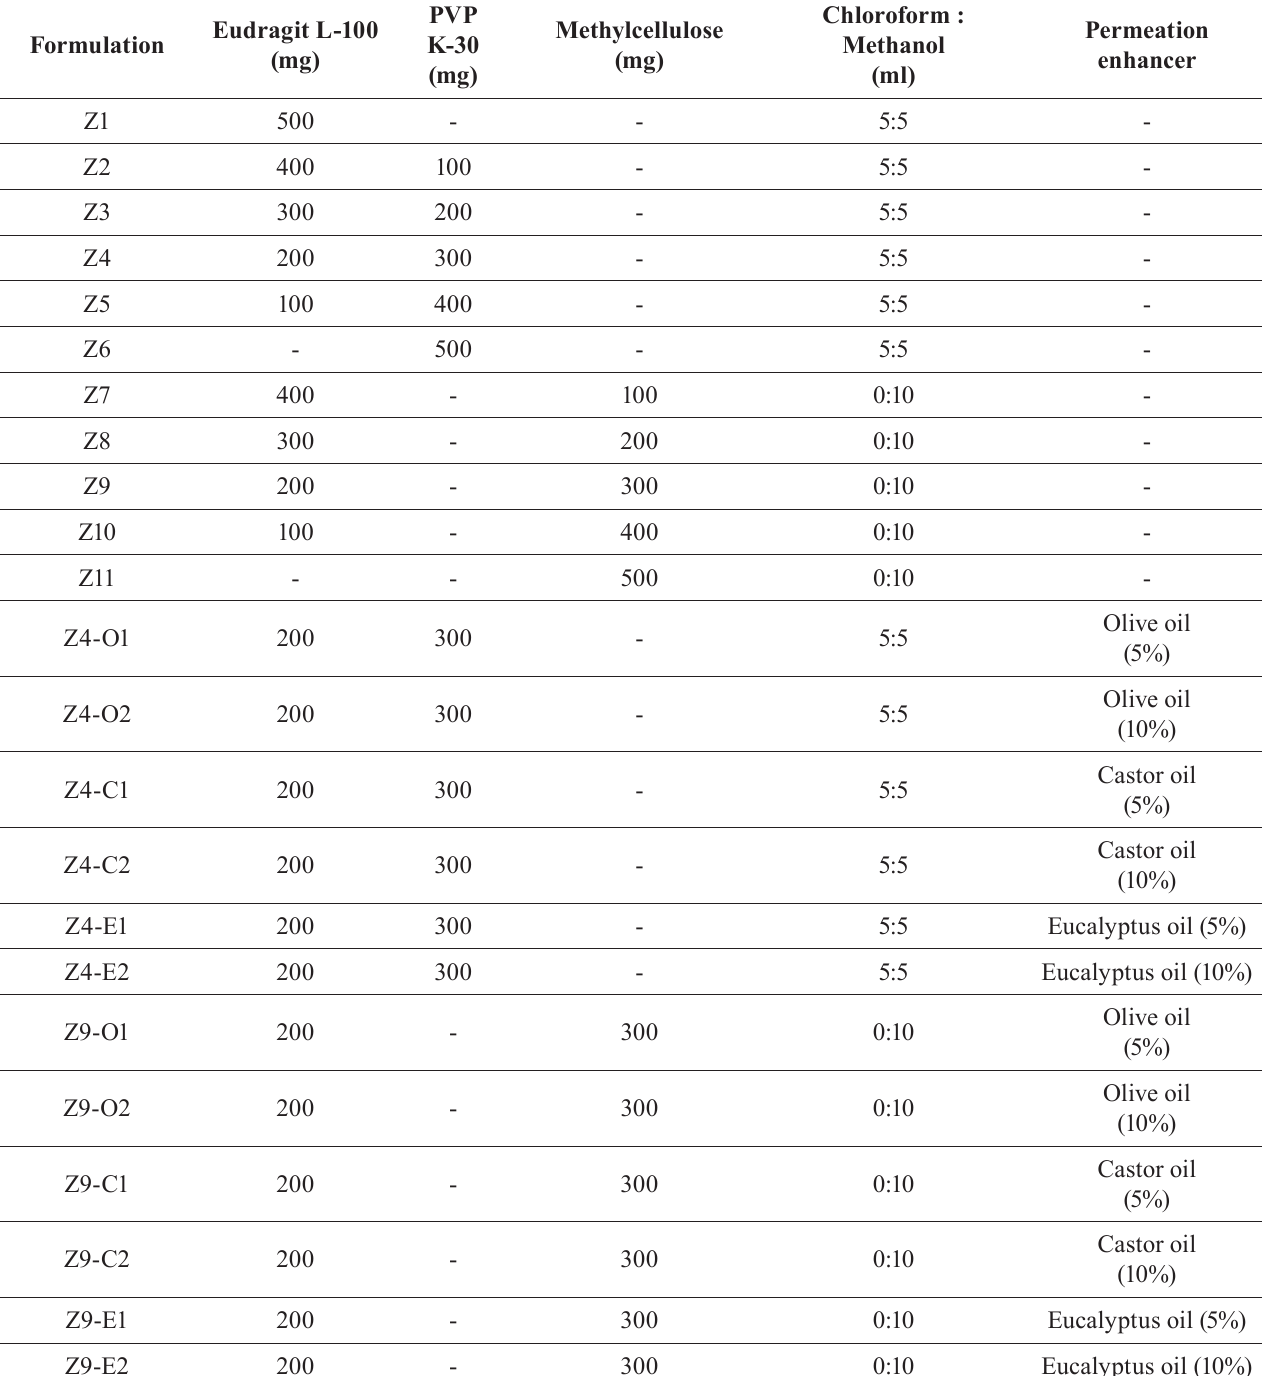
Table I - F ormulation of matrix transdermal patches containing Metoclopramide (10mg) and polyethylene glycol (45% w/w).